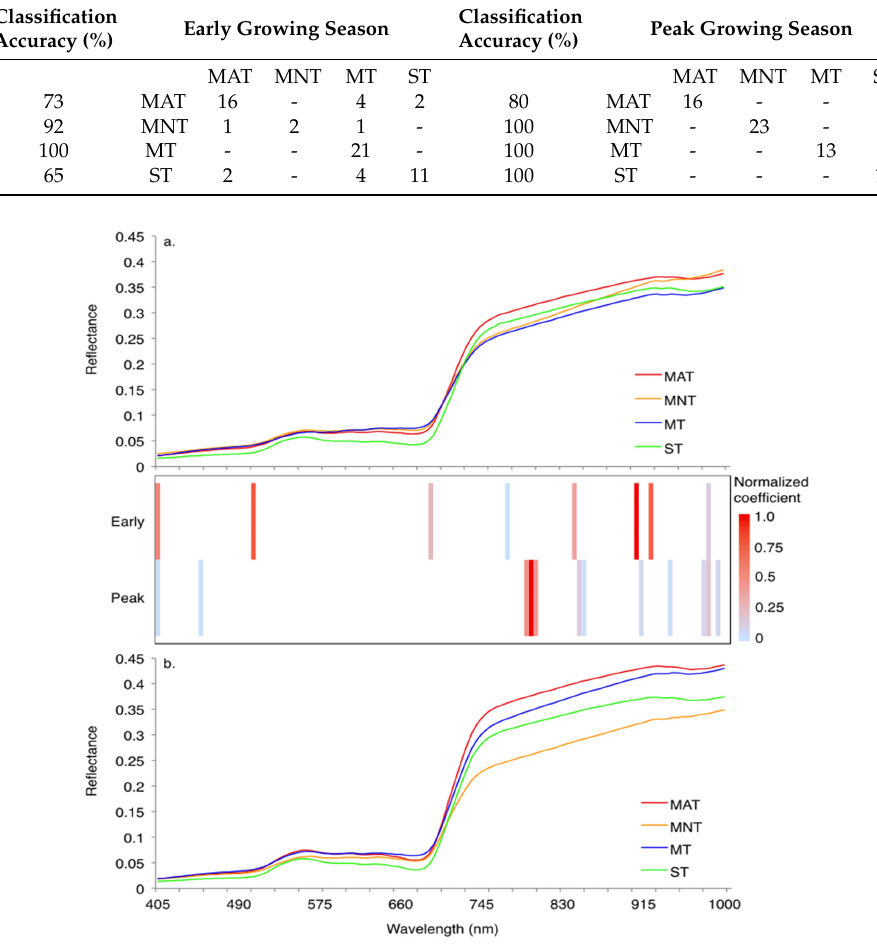
Figure 4. Mean reflectance spectra for the four vegetation communities during early ( a ) and peak ( b ) growing season at Ivotuk, Alaska in 1999. Reflectance spectra are shown along with the top ten percent of optimal hyperspectral narrowbands (HNBs) and their normalized coefficients for the first discriminant function. Table 4. Confusion matrices and classification accuracies at Ivotuk, Alaska using the top ten percent Remote Sens. 2016 , 8 , 51 of significant hyperspectral narrowbands (HNBs). Classification Accuracy (%)